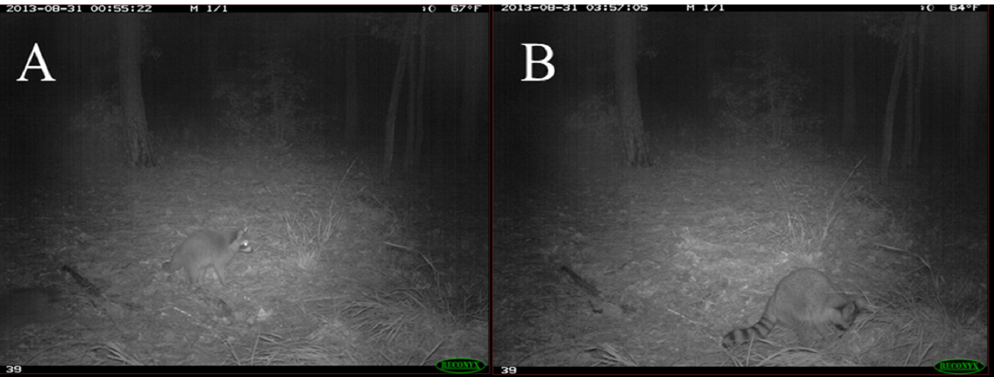
Figure 1. Vigilant raccoons had a crook where the neck meets the body and may have been standing on hind legs; they were classified “head up” ( A ). Foraging raccoons had a characteristically sloping back and neck and were classified “head down” ( B ).